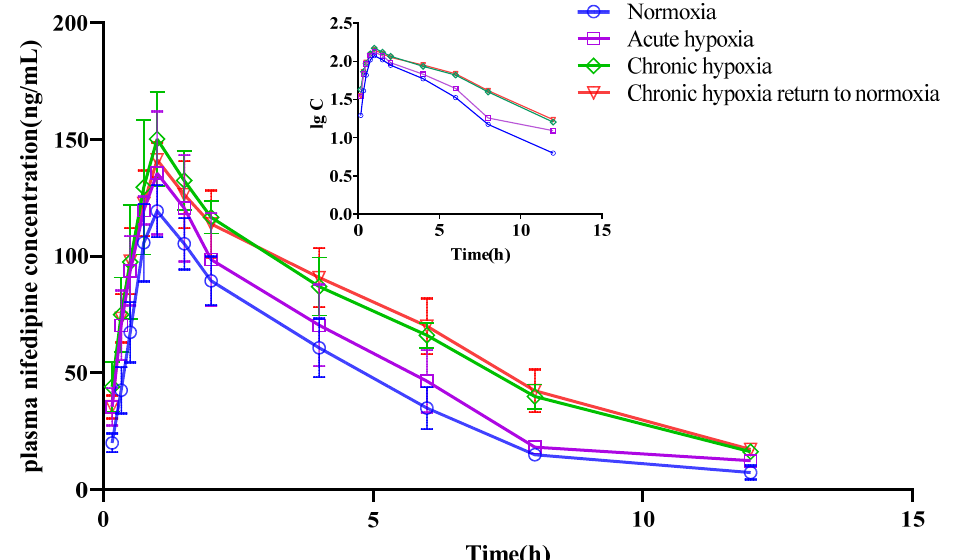
Figure 8. Mean plasma concentration time curve of nifedipine for rats after exposure to high-altitude hypoxia ( n = 8).